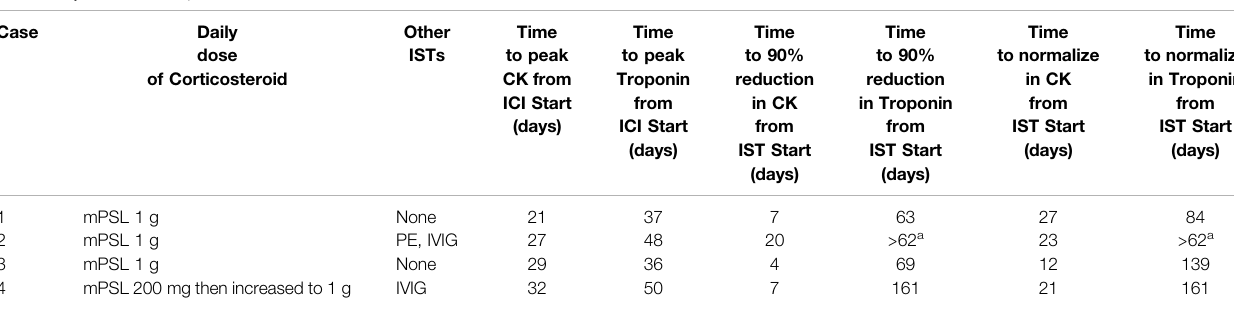
TABLE 2 | Treatment responsiveness of our institutional cases.